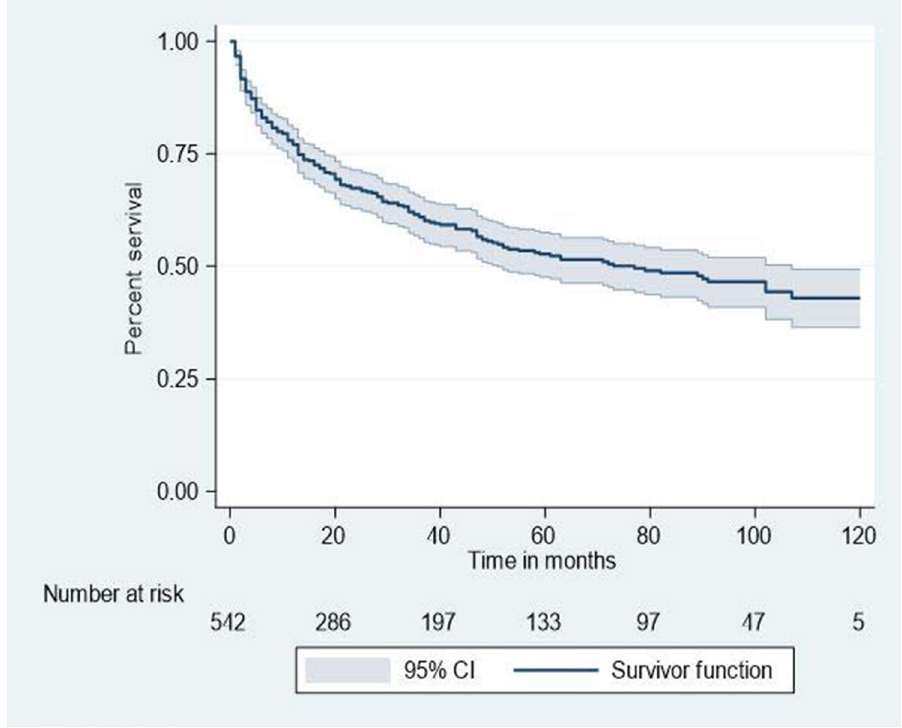
Figure 1. Overall survival estimates among HIV patients in Bichena health center, Amhara, North West Ethiopia, January 1, 2008–December 30,